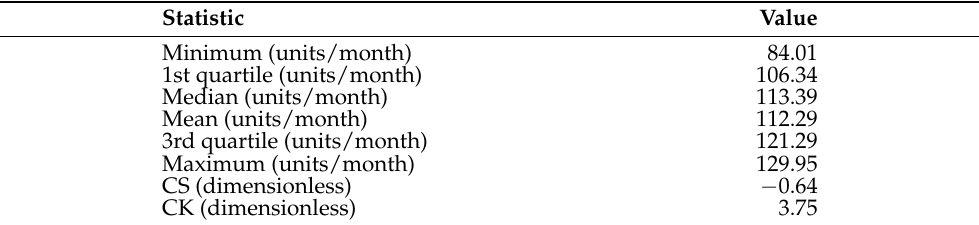
Table 12. Descriptive statistics for the monthly drug DPUT data.